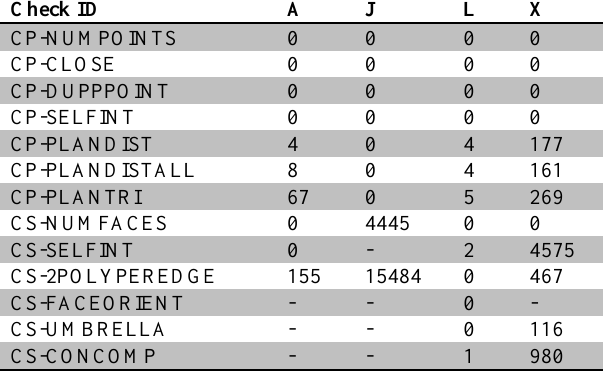
Table 1. Results for geometry validation